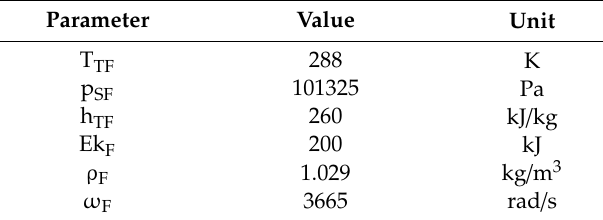
Figure 10. Static pressure trendlines. Figure 11. Total enthalpy trendlines.